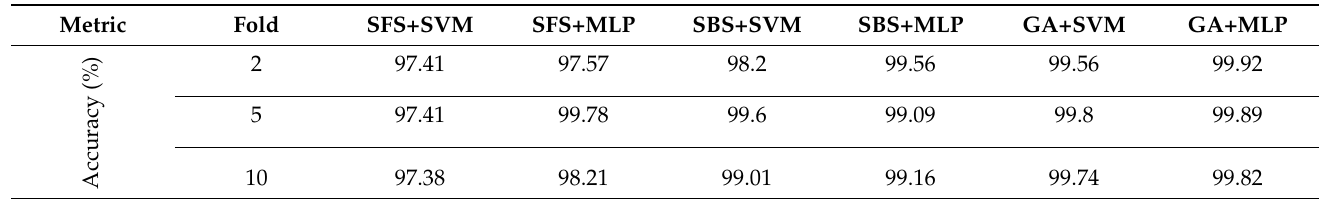
Table 11. Performance of SFS, SBS, and GA using objective function based on DR, FPR, and number of selected features in